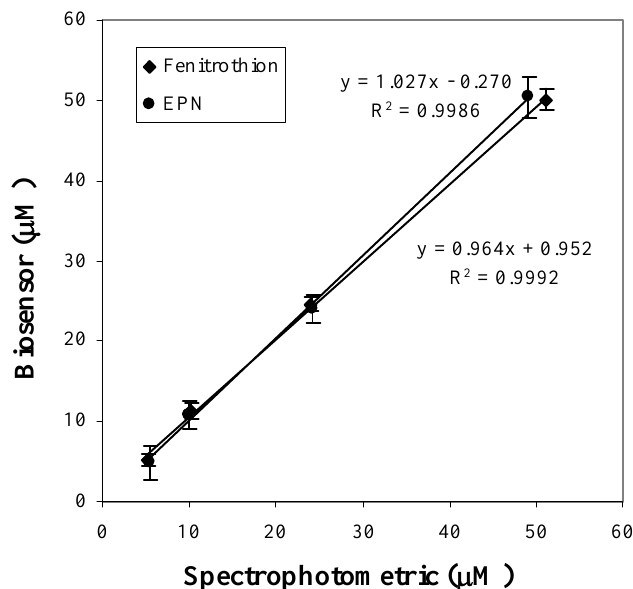
Figure 2. Accuracy of microbial biosensor. Fenitrothion and EPN as target compounds and operating in 50 mM pH 7.5 citrate-phosphate buffer with 50 µ M CoCl loading. Data are given as mean ± 1 standard deviation for three